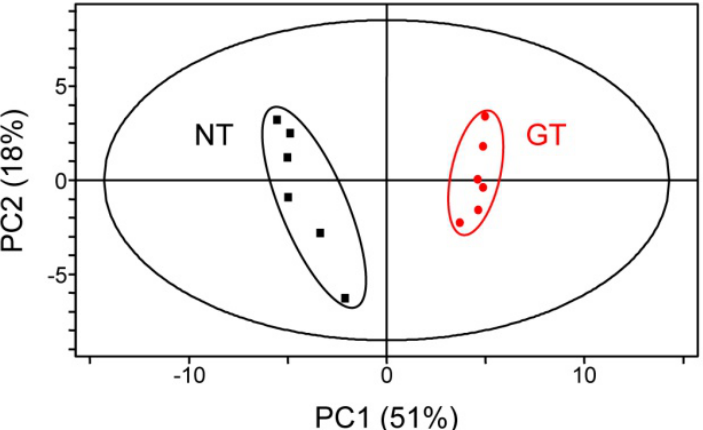
Figure 5. Principal component analysis (PCA) of untargeted negatively charged metabolic profile. PCA was performed using Simca-P11. Black squares and red circles represent samples obtained from mature seeds of NT and GT,